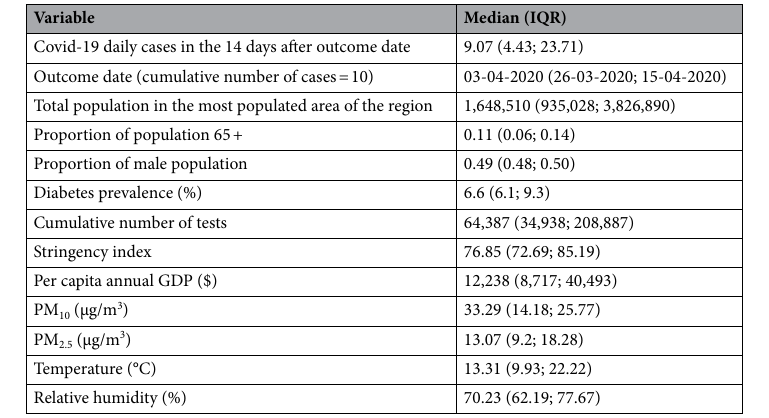
Table 1. Environmental, socio-demographic and Covid-19 median and interquartile range. Cumulative number of Covid-19 tests, Government Response Stringency Index at outcome date; temperature and relative humidity in the 30 days before the outcome date. PM levels refer to mean daily levels recorded over 2015–2018.